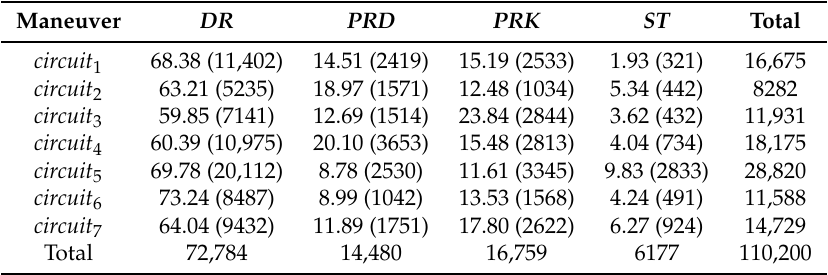
Table 1. Distribution of instances among maneuvers and circuits in terms of percentage and total number (in brackets).